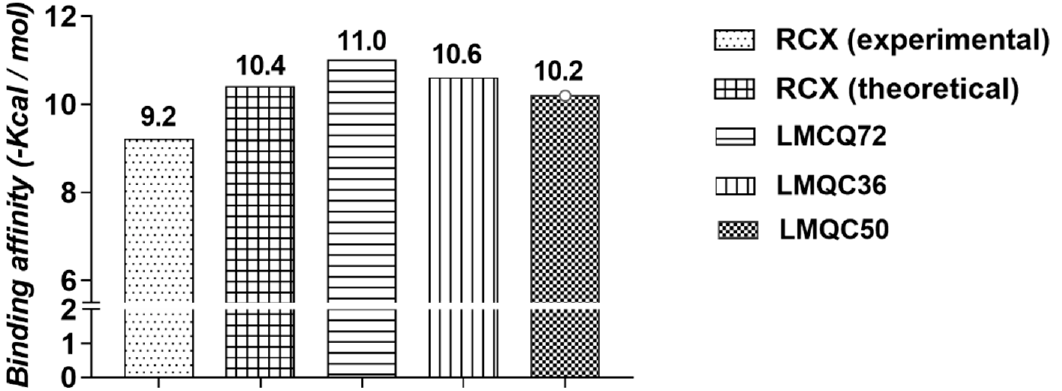
Figure 4. Binding a ffi nity values (Kcal / mol) of the most promising compounds to h Figure 4. Binding affinity values (Kcal/mol) of the most promising compounds to h COX-2.